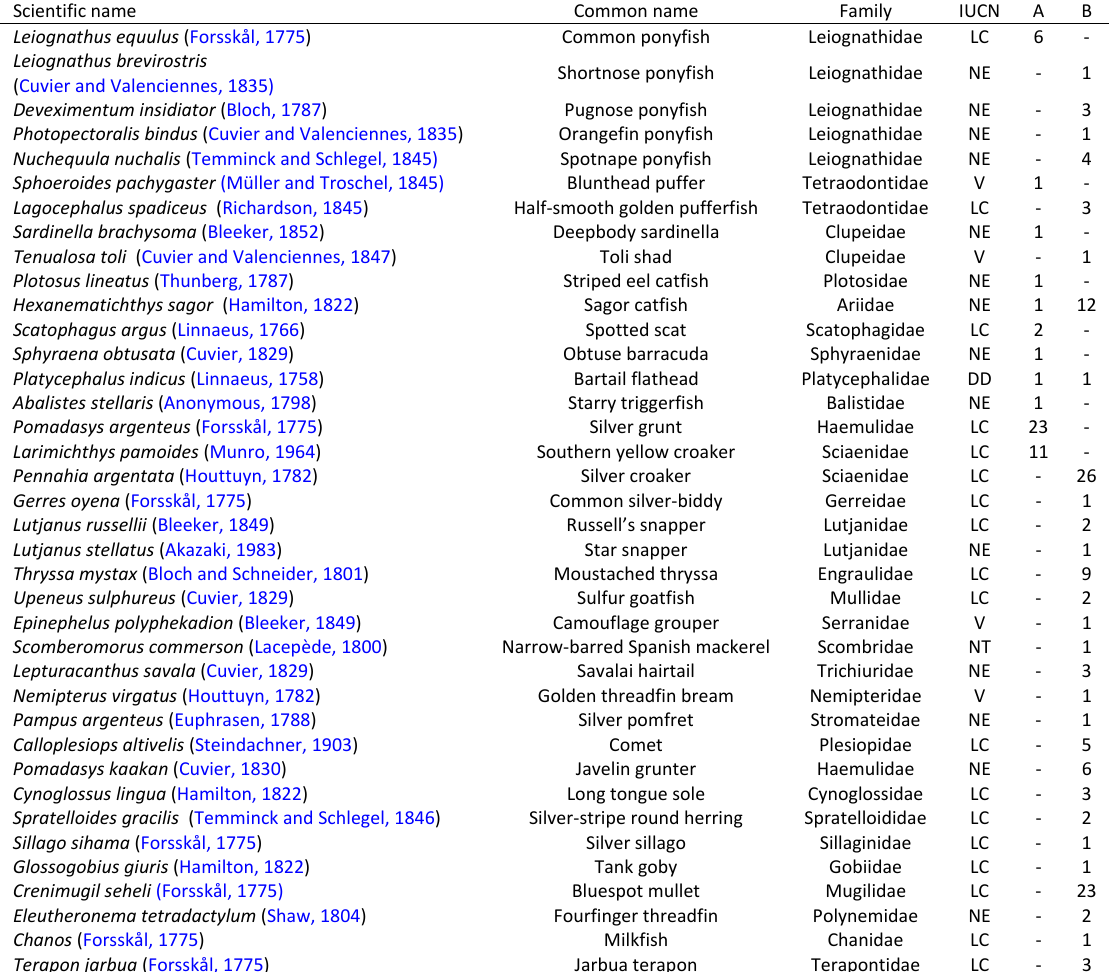
Table 2: Fish species list recorded with family, common name, and individual abundance at disturbed (A) and intact (B) sites on West Java coast Scientific